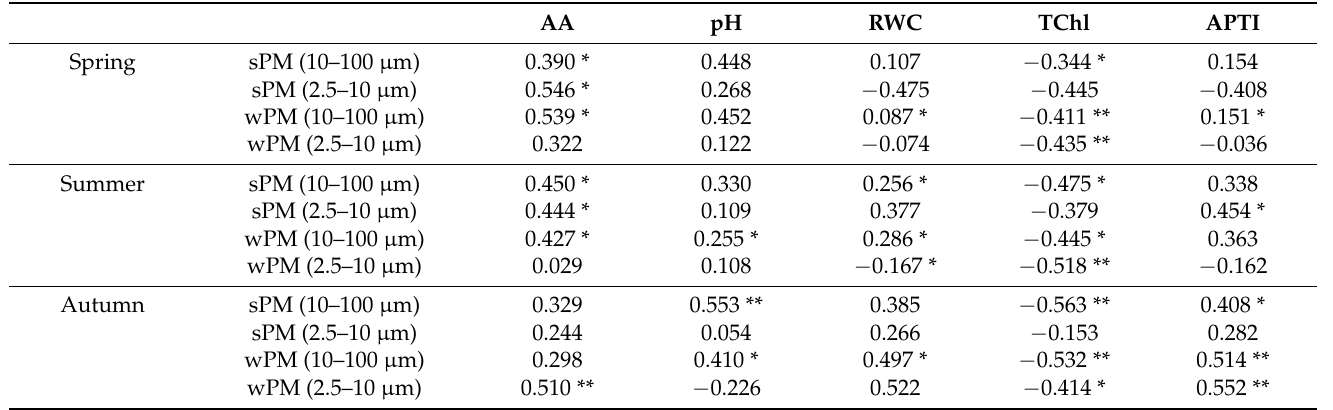
Table 4. The correlation between PM accumulation on leaves, leaf traits, and the APTI of five plant species. AA pH RWC